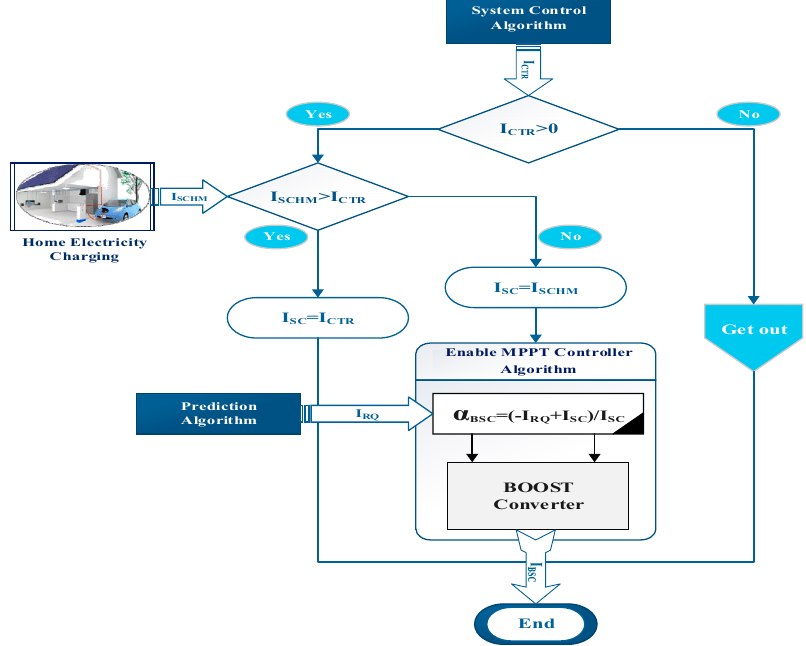
Figure 4. Emergency control algorithm.